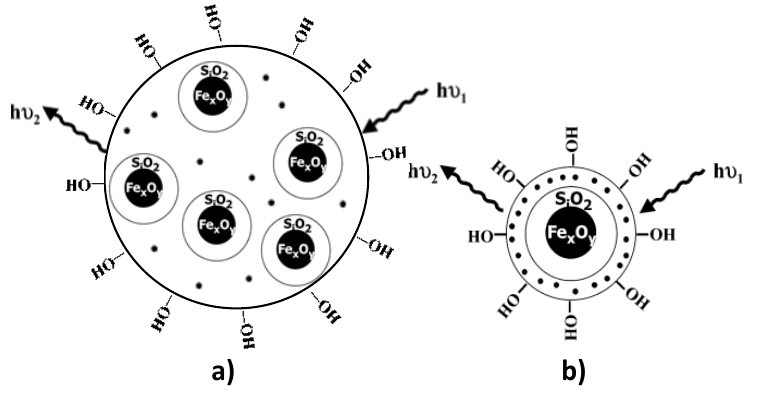
Figure 21. Iron oxide NPs are embedded in a mesoporous silica matrix, in which lanthanide cations are dispersed, within ( a ) a multicore and ( b ) a single core morphology.